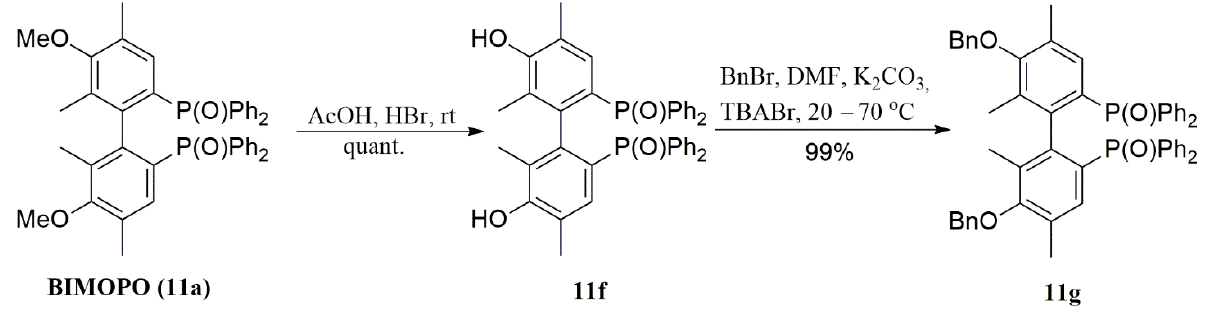
Figure 6. X ‐ ray structure of (S) ‐ ( ‐ ) ‐ BIMAPO (solvent molecule and hydrogen atoms were omitted for clarity), its CD spectrum (black) as well the CD spectrum of (R) ‐ MeO ‐ BIPhEPO